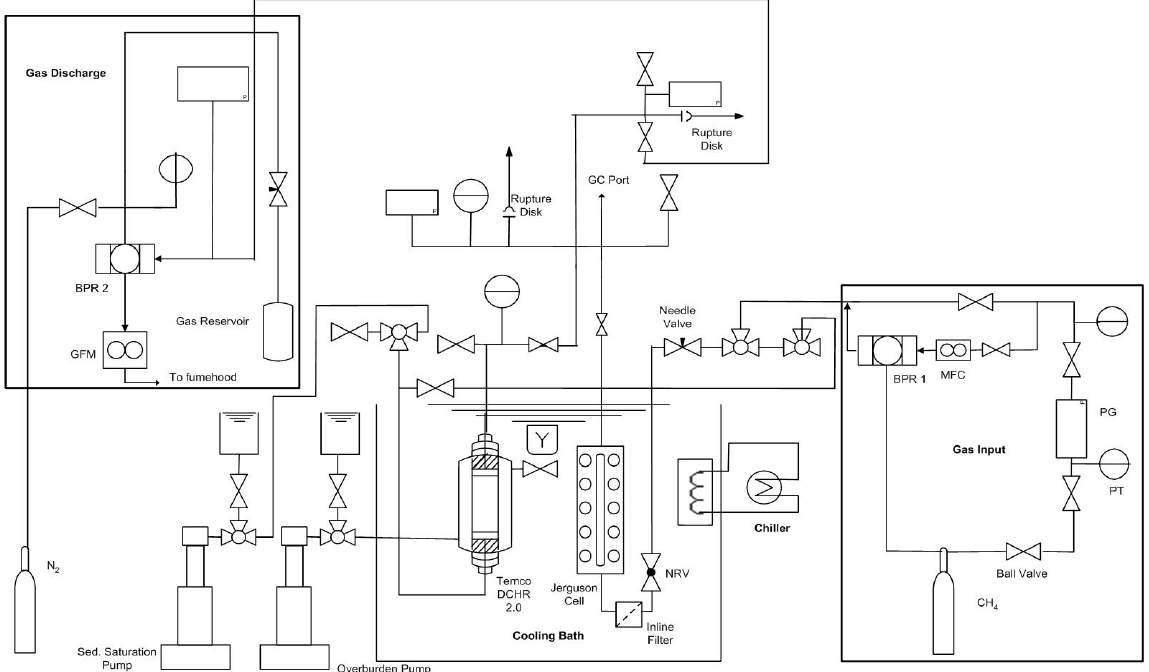
Figure 2. Set-up of the Flexible Integrated Study of Hydrates (FISH) Unit. The heart of the unit is a Jerguson cell fitted with glass windows that served as a high-pressure vessel to mimics seafloor conditions for the